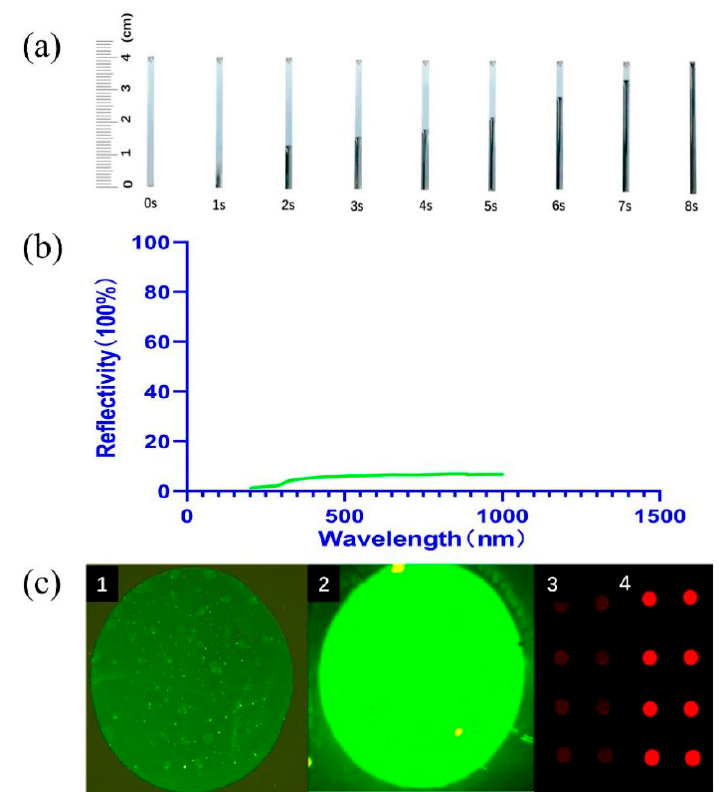
Figure 6. Characterization of nanoforest structure. ( a ) Flow rate test of silicon nanoforest chip recorded in 1 s intervals. The flow speed of PBS was recorded by the distance traveled per second. ( b ) Reflectance for nanoforest structure on silicon substrate. ( c ) Scheme of the silicon nanoforest chip under fluorescence microscope: (1) silicon-based plane in 488 nm wavelength; (2) nanoforest structure in 488 nm wavelength; (3) silicon-based plane in 688 nm wavelength; (4) nanoforest structure in 688 nm